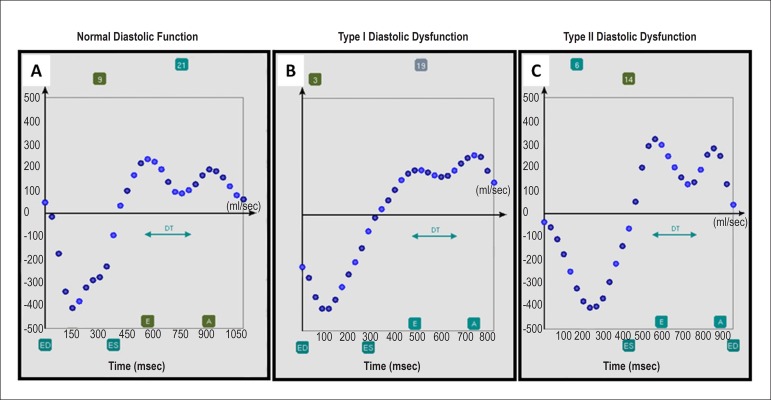
Screenshots of different diastolic function examples using the
program CIM. A) Normal, B) impaired, and C) reduced. The following
measurements were assessed: end-systole (ES), end-diastole (ED),
early peak filling rate (E), atrial peak filling rate (A), and
deceleration time (DT). All timing measurements were defined
semiautomatically with manual correction with the observer using a
slider on the time/rate curve.